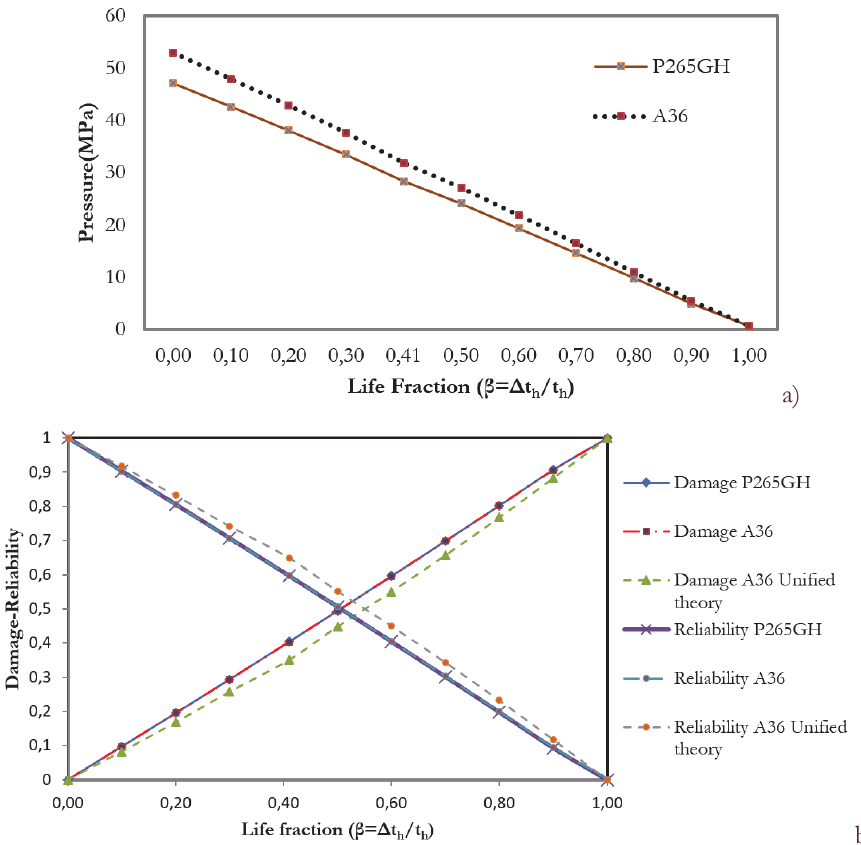
Figure 3: Failure pressure (a) and Damage and reliability (b) of P265GH and A36 function of the ratio notch depth-thickness.